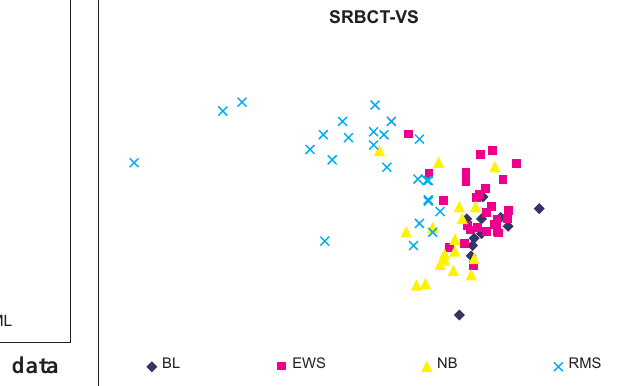
Figure 5.4: Two-Dimensional View of SRBCT data set produced by VS method with very little class separation.